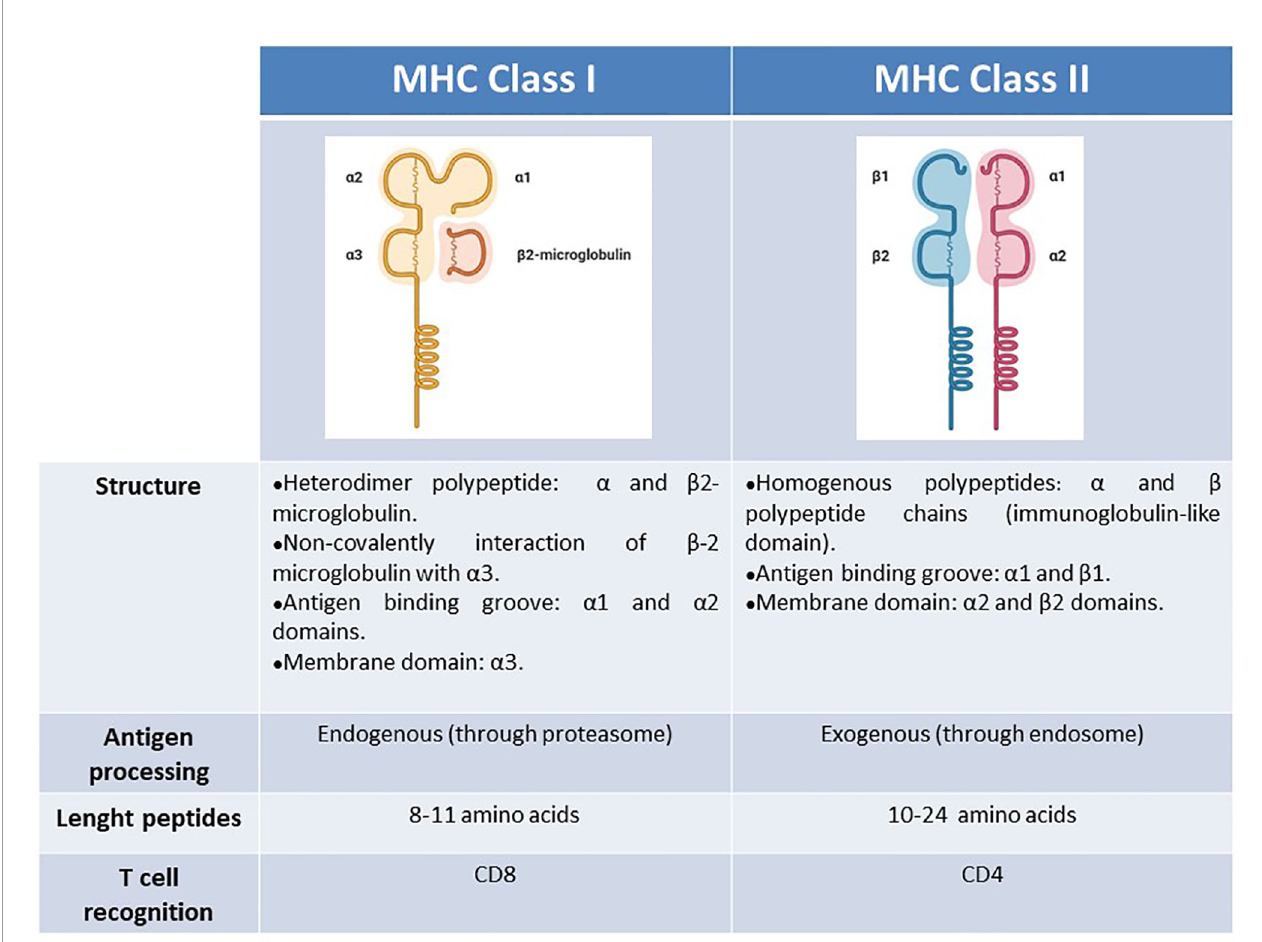
FIGURE 1 | Schematic summary of MHC characteristics. Structure, antigen processing, peptides length, T-cell